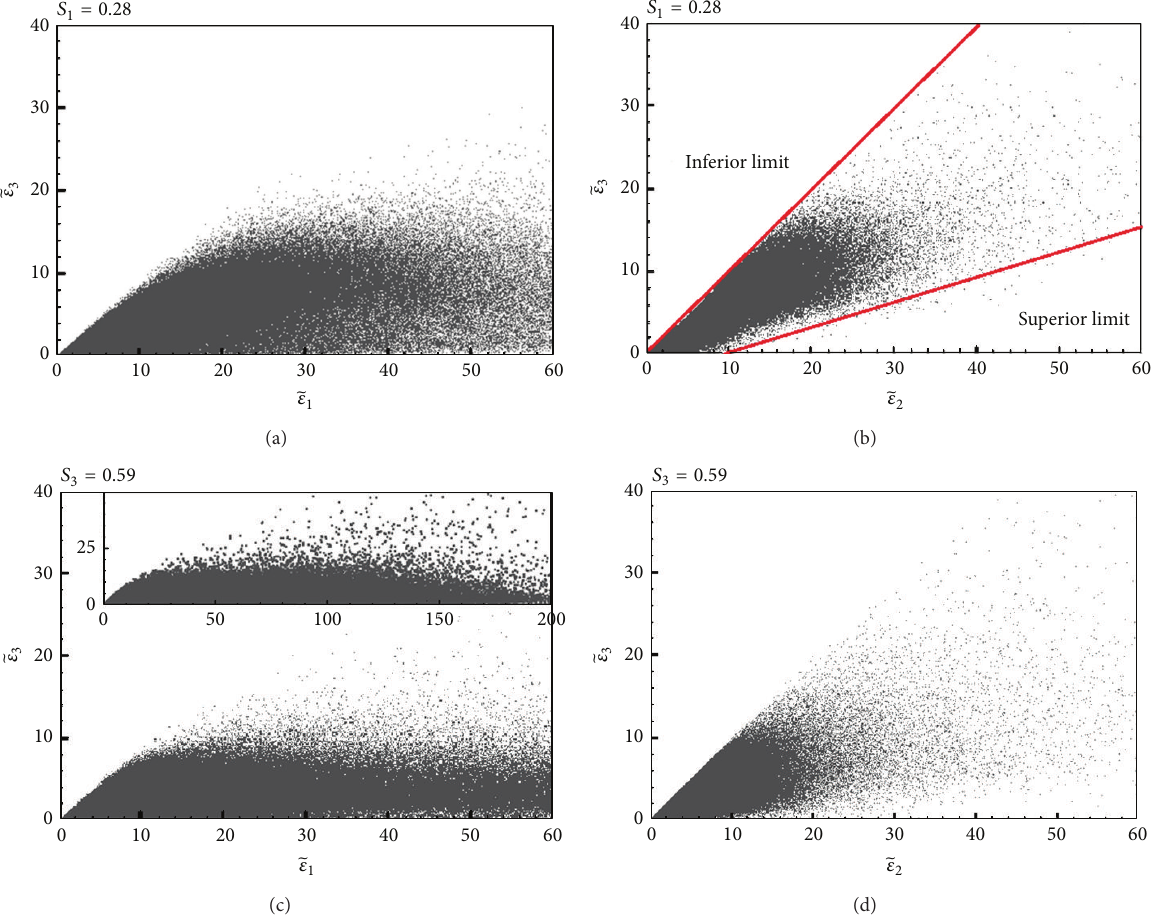
Figure 4: Relation of eigenvalues. (a) 𝑆 1 = 0.28 , ̃𝜀 1 ∼ ̃𝜀 3 ; (b) 𝑆 1 = 0.28 , ̃𝜀 2 ∼ ̃𝜀 3 ; (c) 𝑆 3 = 0.59 , ̃𝜀 1 ∼ ̃𝜀 3 ; (d) 𝑆 3 = 0.59 , ̃𝜀 2 ∼ ̃𝜀 3